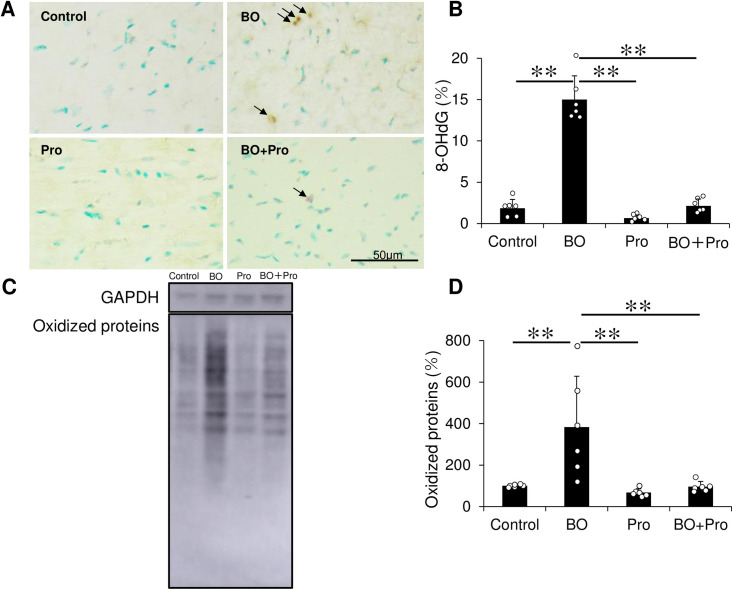
Effects of BO on oxidative stress in cardiac muscle.(A) Representative images of immunohistochemical detection of oxidative DNA damage (8-OHdG) in cardiac muscle in the Control (upper left), BO (upper right), Pro (lower left) and BO + Pro (lower right) groups. (B) 8-OHdG-positive nuclei was significantly increased in the BO group, but this increase was blocked in the BO + Pro group. **P < 0.01 by one-way ANOVA followed by the Tukey-Kramer post hoc test (S11A Fig of S1 Data). (C) Representative SDS-PAGE of oxidized proteins in cardiac muscle homogenate prepared from Control (lane 1), BO (lane 2), Pro (lane 3) and BO + Pro (lane 4) groups using the OxiSelectTMProtein Carbonyl Immunoblot Kit. (D) Oxidized proteins were significantly increased in the BO group, but this increase was blocked in the BO + Pro group. **P < 0.01 by one-way ANOVA followed by the Tukey-Kramer post hoc test (S11B Fig of S1 Data). Data expressed as means ± SD and scattered dots show individual data.